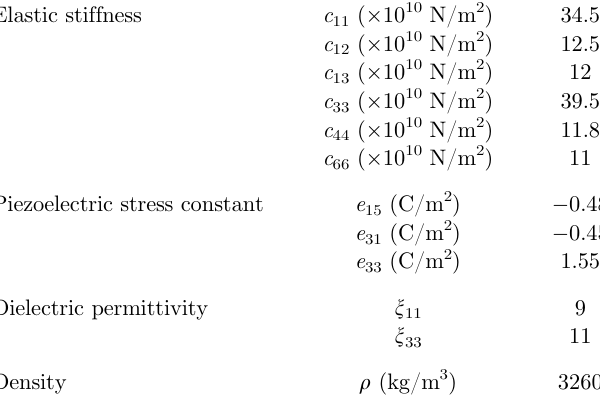
Table 2. Material constants of AlN used in the calculation [16].